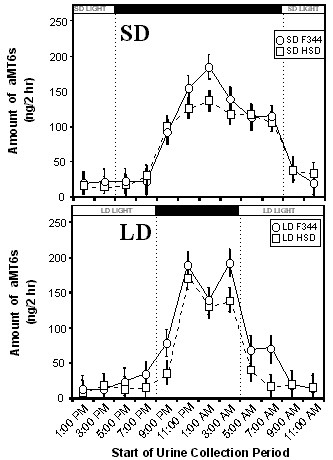
24-hour urinary 6-sulfatoxymelatonin excretion rhythms (ng/2 h) for F344 and HSD rats in SD (upper panel) and LD (lower panel). Values shown are means +/- SEM. Bars at the top of the figure indicate periods of light and dark for the SD and LD treatments, respectively. For each treatment group, n = 12 rats.